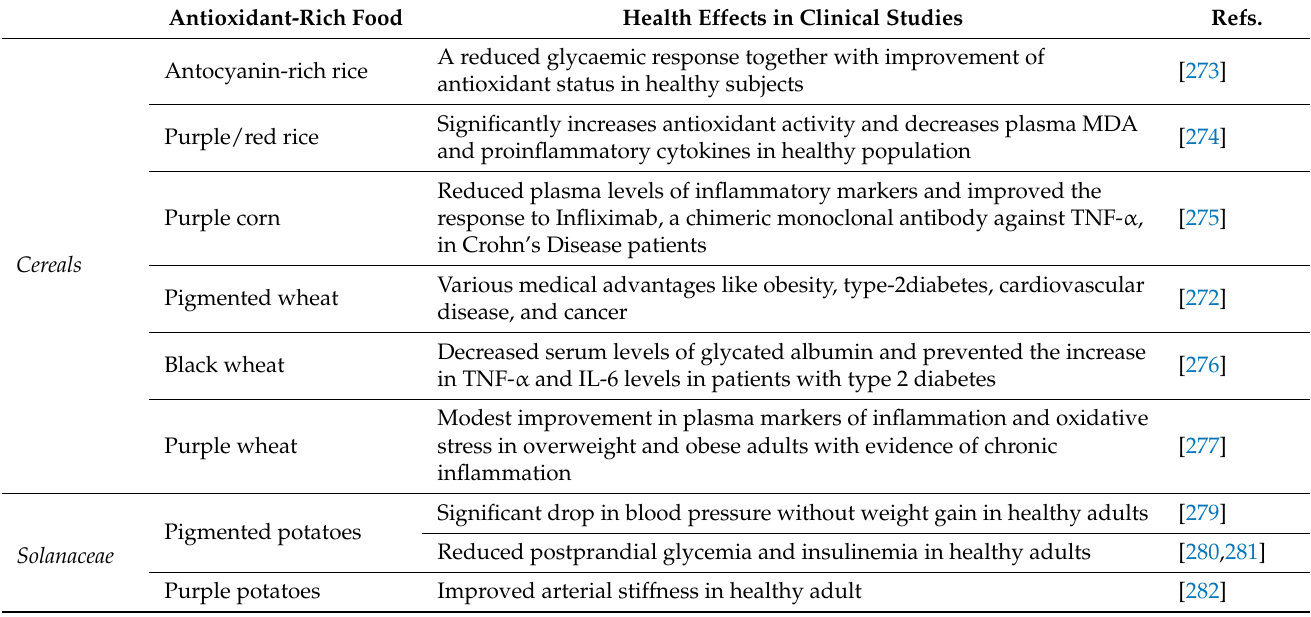
Table 5. Health effects of antioxidant-rich foods in clinical studies. MDA, malondialdehyde; HCD, high-caloric diet; HCD, TNF- α ,Tumor Necrosis Factor- α ; and DNA, deoxyribonucleic acid. Antioxidant-Rich Food Health Effects in Clinical